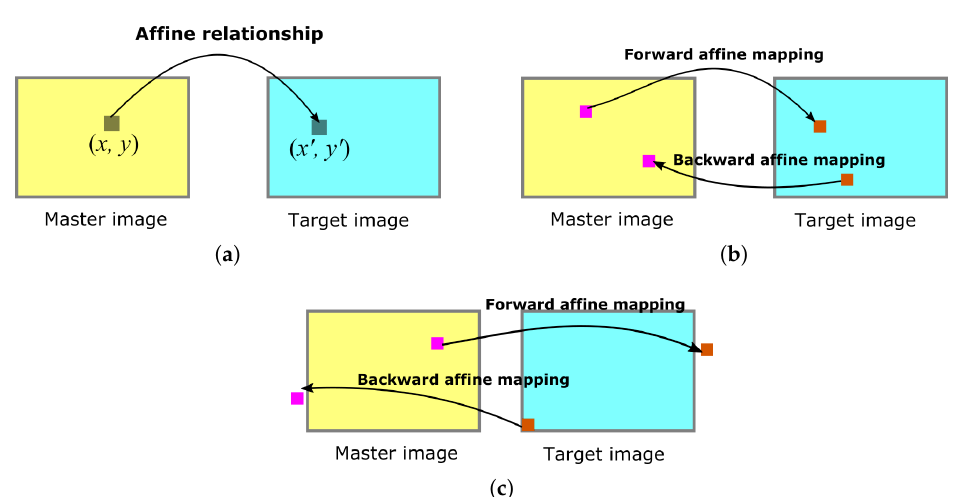
Figure 5. Affine transformation and bounding box processing for retrieving a high number of feature correspondences: ( a ) solving the affine parameters by seed matching, ( b ) geometrically mapping the keypoints, and ( c ) filtering matches outside the